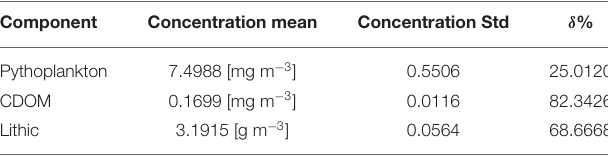
TABLE 7 | MCMC outputs for example